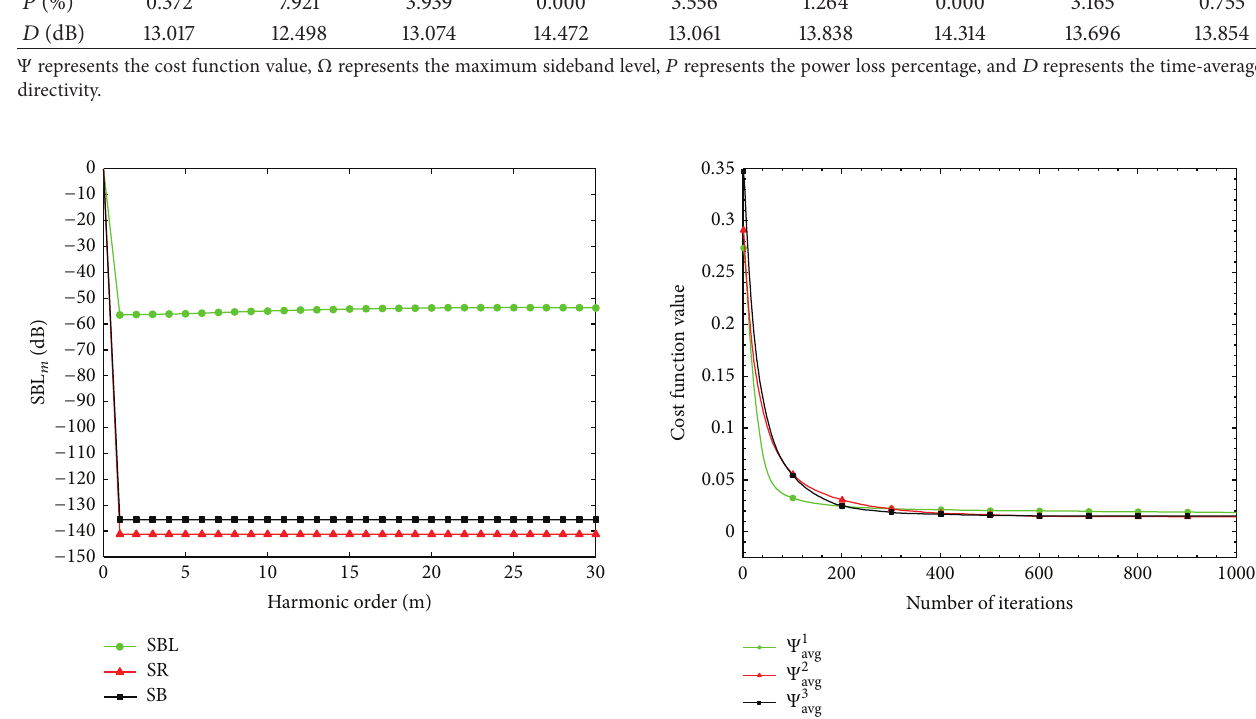
Figure 8: The average convergence behaviour of the three methods for IS— Ψ 𝑘 represents the cost function value and 𝑘 represents the method used, where 𝑘 = 1 : SBL, 𝑘 = 2 : SR, and 𝑘 = 3 :